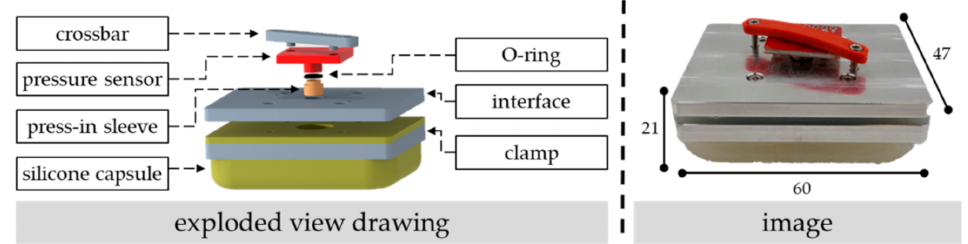
Figure 1. Exploded view drawing ( left ) and image ( right ) of the developed sensor pad. The dimen- sions are given in